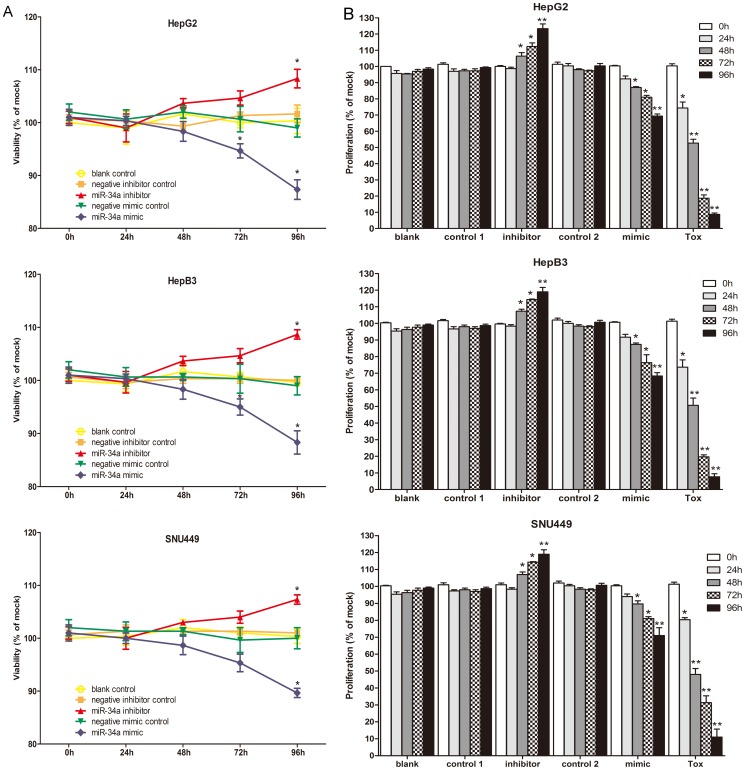
Effect of miR-34a on cell growth in HCC cells.HepG2, HepB3 and SNU449 cells (2.5×103 cells per well in 96-well-plate) were cultured for one day and then transfected with miR-34a inhibitor, miR-34a mimic and their controls (200 nM). (A) Time dependent effect detected by CellTiter-Blue Cell Viability assay. (B) Cell proliferation assessed with MTS assay. * P<0.05, ** P<0.01, compared to blank and negative controls at the same time point. TOX: TOX positive transfection control.